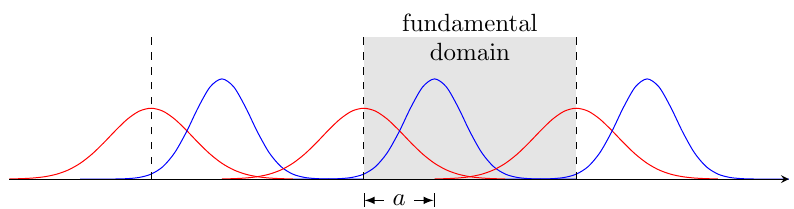
Figure 2. Overlap of two Gaussians on a torus. The overlap of a given, say red, curve is not just the overlap with one blue curve but with infinitely many of them, thus leading to an expression of the form (4.67).